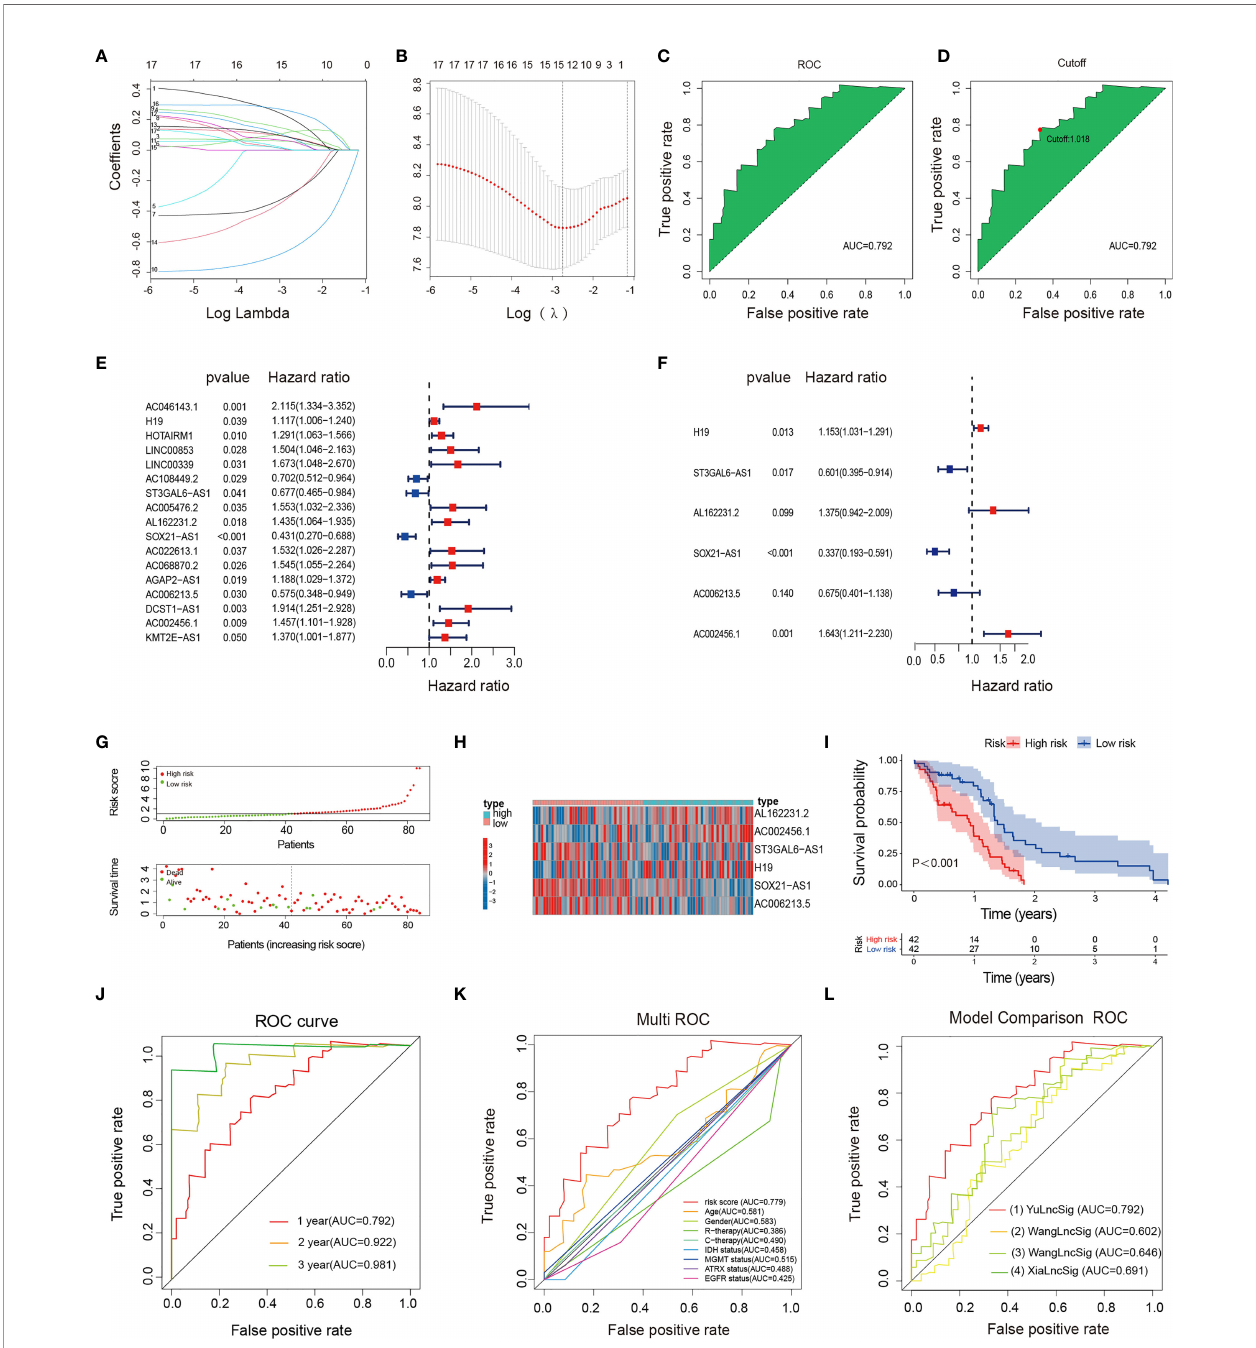
FIGURE 2 | Construction, evaluation, and comparison of a risk signature. (A) LASSO coef fi cient pro fi les of the 17 irlncRNAs in the training set. (B) A coef fi cient pro fi le plot was generated against the log (lambda) sequence. Selection of the optimal parameter (lambda) in the LASSO model. (C, D) The AUC value and cutoff point obtained in the training set. (E) Forest plot of 17 irlncRNAs selected by univariate Cox regression analysis associated with GBM survival in the training set. (F) Forest plot of six irlncRNAs selected by multivariate Cox regression analysis associated with GBM survival and construction risk model. (G) Risk score and survival status analysis of irlncRNAs prognostic signature. (H) The expression pattern of irlncRNAs prognostic signature in the low- and high-risk groups. (I) Survival analysis of irlncRNAs prognostic signature. (J) ROC curve analysis within 1, 2, and 3 years. (K) Multivariate ROC curve analysis showing that the superior prognostic performance of the irlncRNAs prognostic model compared to other clinical indicators. (L) AUCs of the ROCs for our and the three other gene